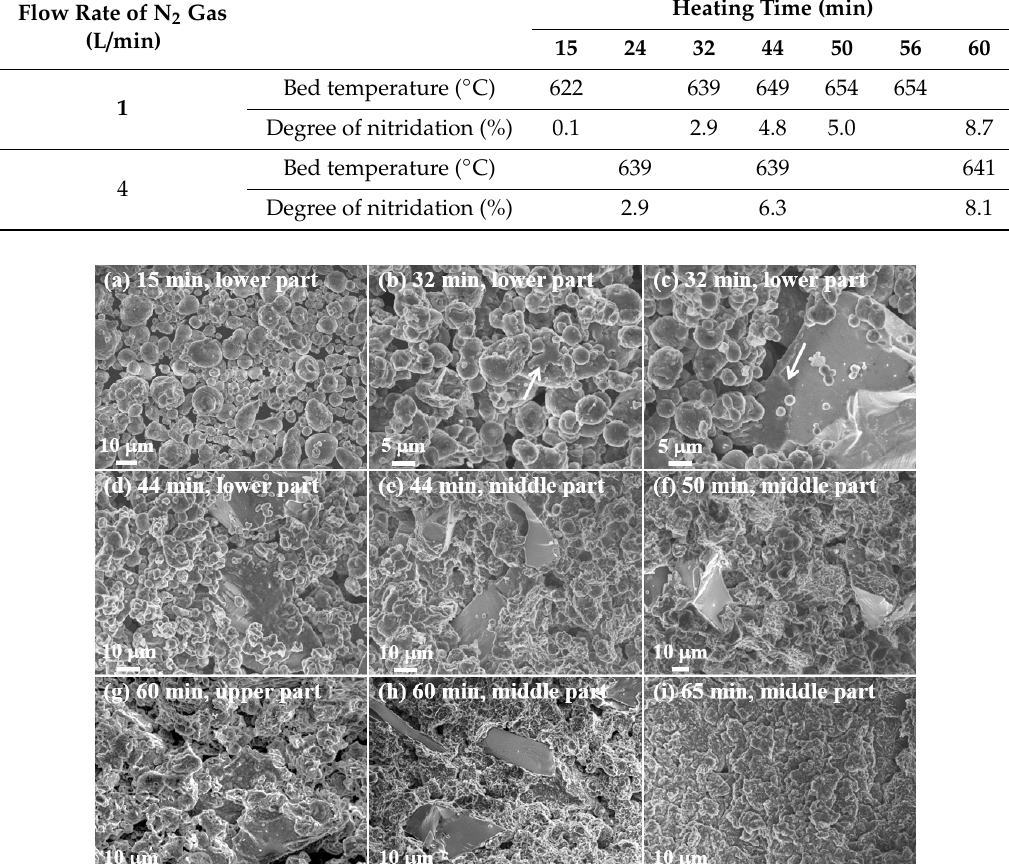
Figure 5. SEM images of the 20 vol.% SiC (40 µ m) / Al 6061 composites at various positions in